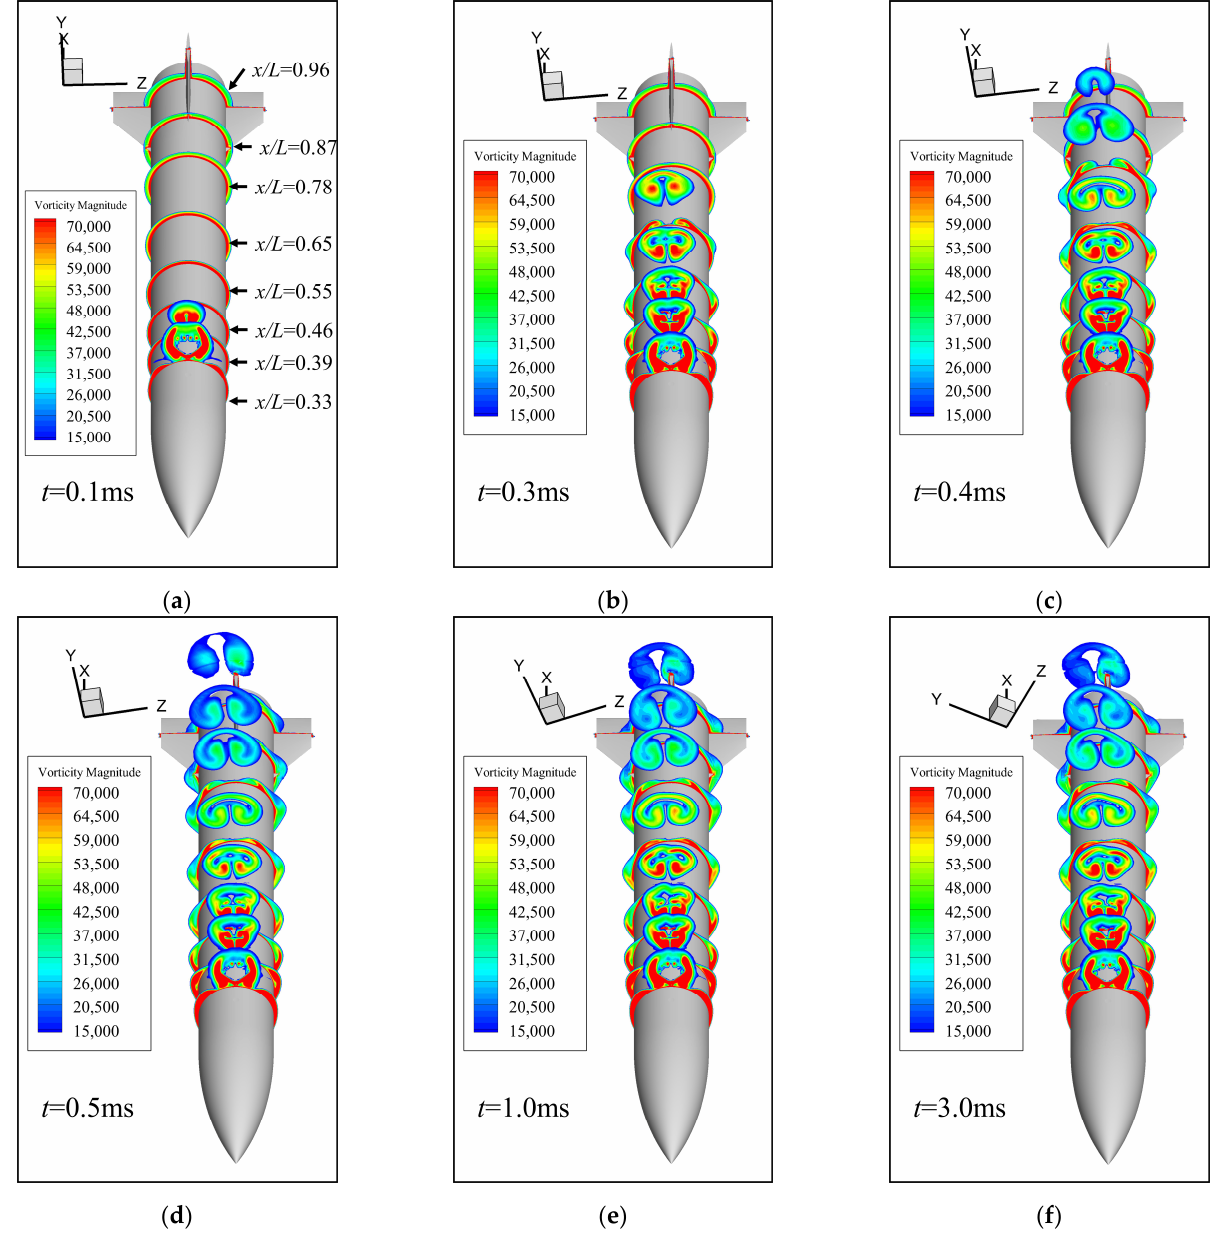
Figure 19. Vorticity magnitude contours in different cross-sections at different times since lateral jet startup: ( a ) t = 0.1 ms, ϕ = 2.13°; ( b ) t = 0.3 ms, ϕ = 6.39°; ( c ) t = 0.4 ms, ϕ = 8.52°; ( d ) t = 0.5 ms, ϕ = 10.65°; ( e ) t = 1.0 ms, ϕ = 21.31°; ( f ) t = 3.0 ms, ϕ = 63.91°.